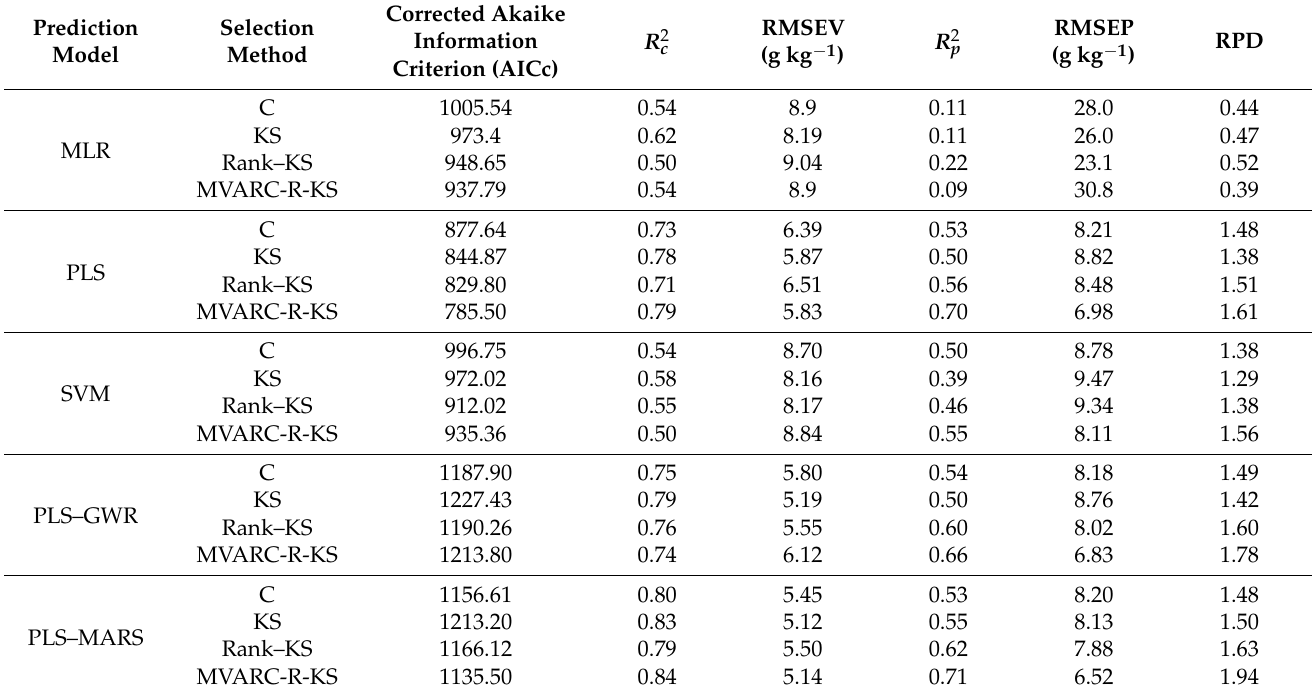
Table 4. Evaluation results of prediction models calibrated by different calibration set selection